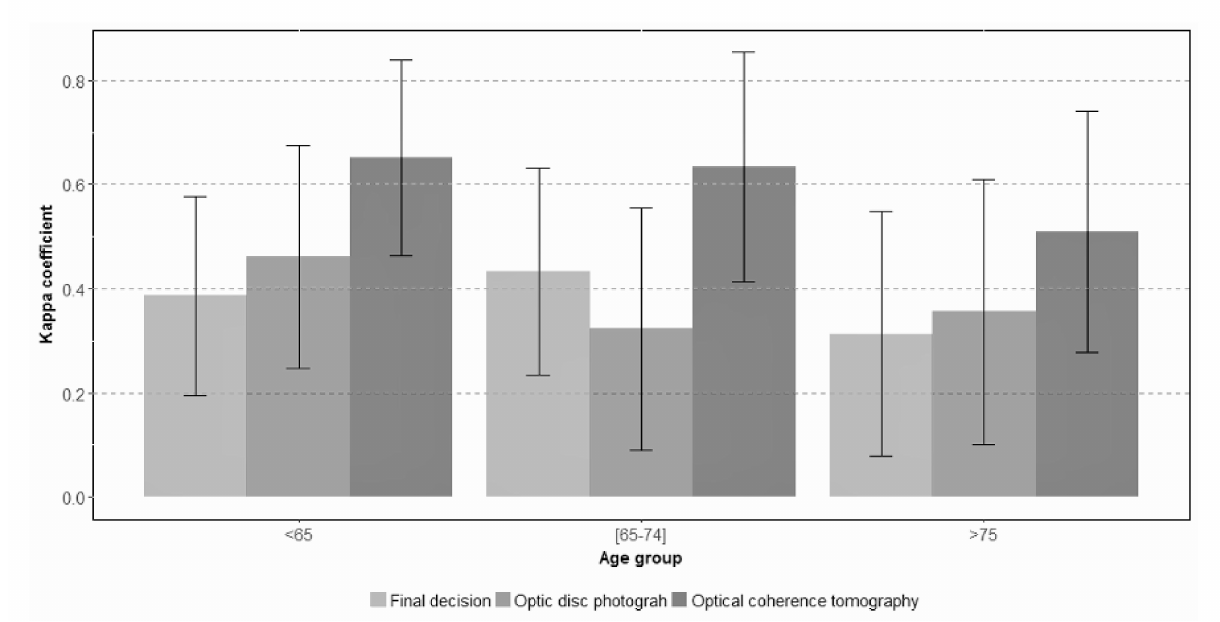
Figure 2. Interobserver agreement between two expert evaluators in each age group. The y axis shows kappa coefficient estimates and their respective confidence intervals. The x -axis shows the three age groups: under 65 years, 65 to 74 years, and over 74 years. Kappa values tend to be greater with younger participant age and on evaluation of OCT images vs. photographs.